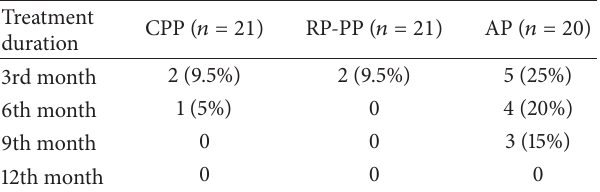
Table 4: The distribution of the patients without HPG axis suppres- sion according to subgroups ( 𝑛 )